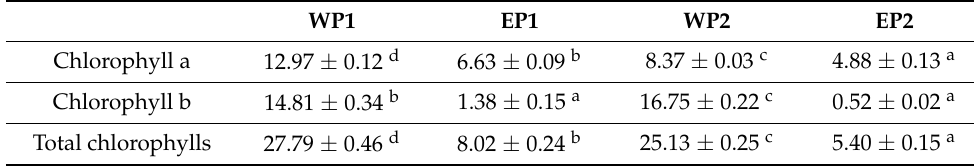
Table 10. Chlorophyl content in pepper (results are expressed as µ g/g